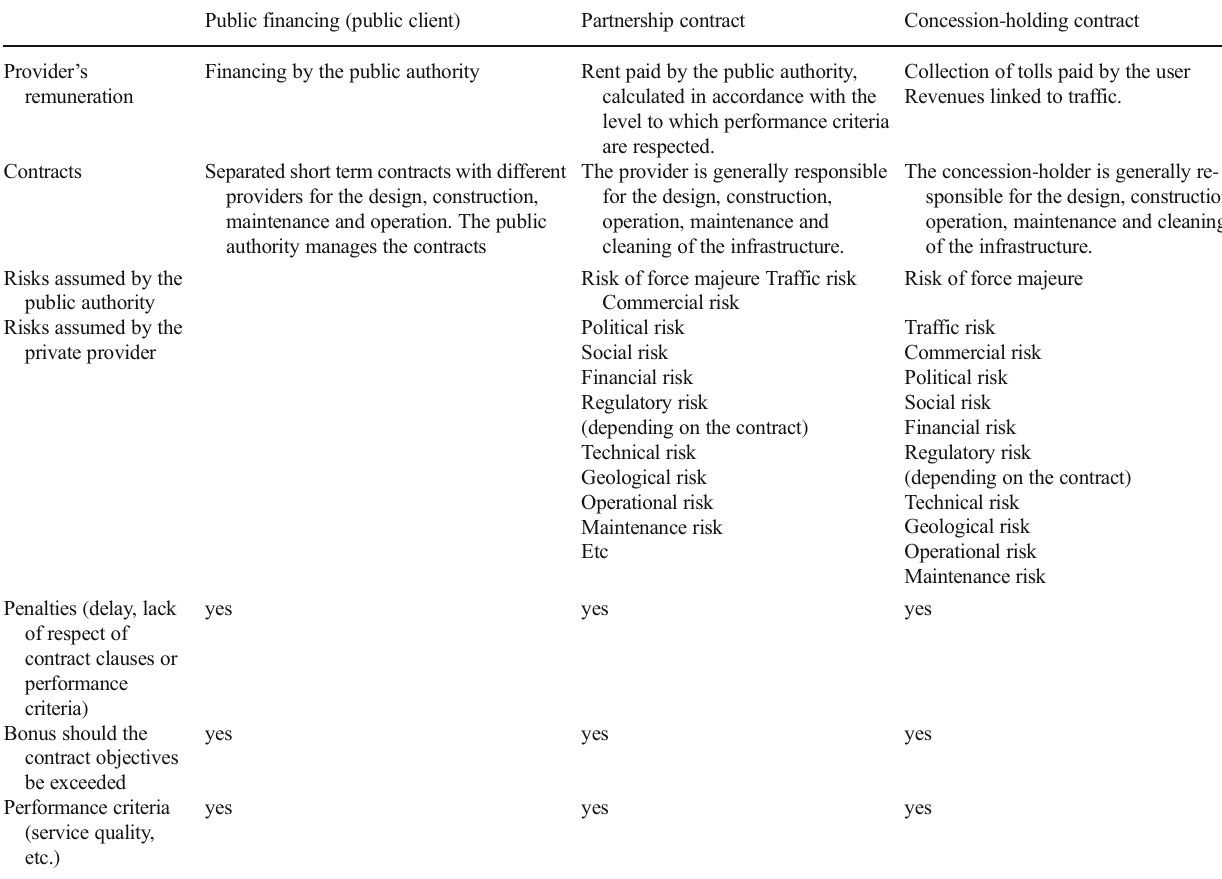
Table 3 Description of the types of financing for transport infrastructures and risk sharing Public financing (public